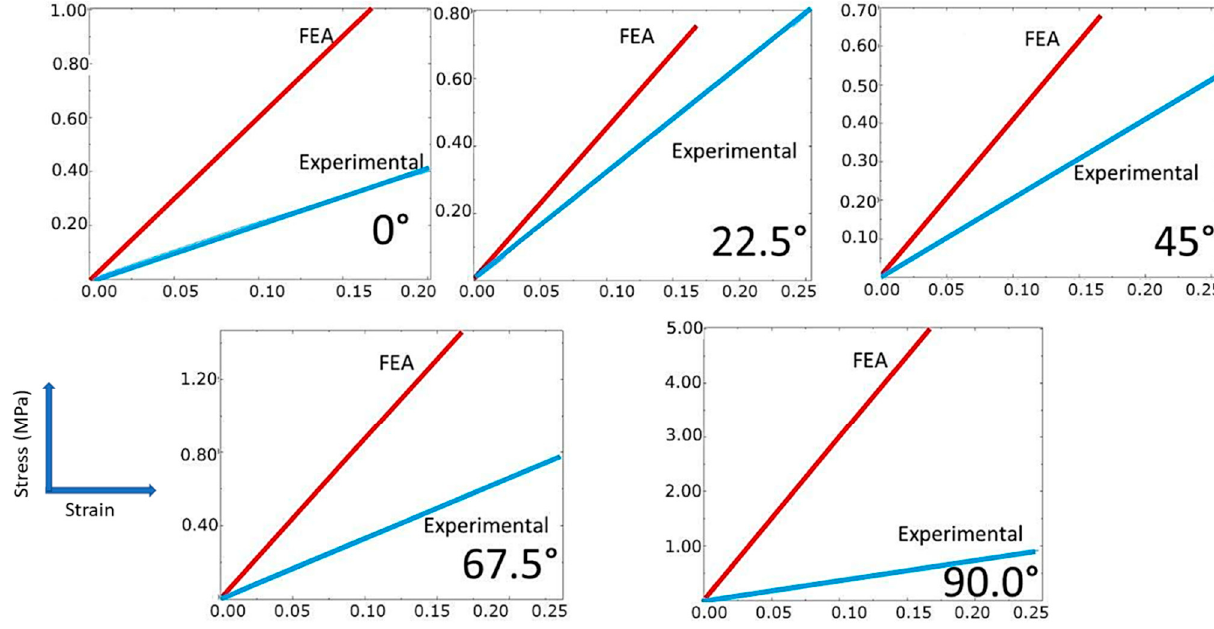
Figure 4. Stress–strain response of nylon/glass fiber composites with different orientations. The maximum experimental stress was 0.40 MPa, 0.80 MPa, 0.52 MPa, 0.77 MPa, and 0.92 MPa for the orientation angles of 0°, 22.5°, 45°, 67.5°, and 90°, respectively, and the maximum strain was 0.20, 0.25, 0.25, 0.24, and 0.25 for the corresponding orientation